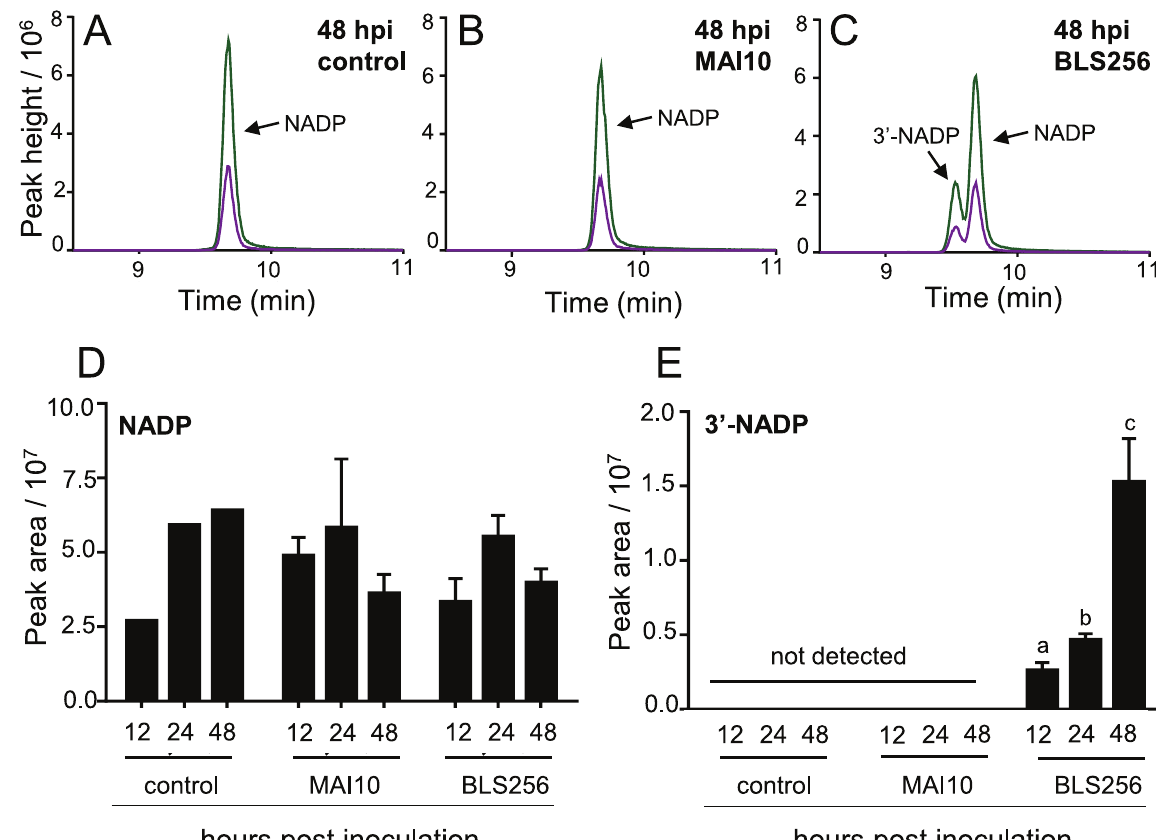
Fig 4. 3’-NADP accumulates in rice leavesupon inoculation with a naturally avrRxo1 -expressing strain of X . oryzae ,but not with an avrRxo1 -deficient strain. (A-C) LC-MS/MS analysisof rice leaves 48 h after infiltrationwith water (A), the avrRxo1- negative strain Xanthomonas oryzae pv. oryzicola MAI10 (B), or the avrRxo1- positive strain BLS256(C). (D-E) Relativepeak area of NADP (D) and 3’-NADP (E) in three biologicalreplicates (means ± SEM, n = 3). Letters denote treatments statistically different from the 12h timepoint(p < 0.05).